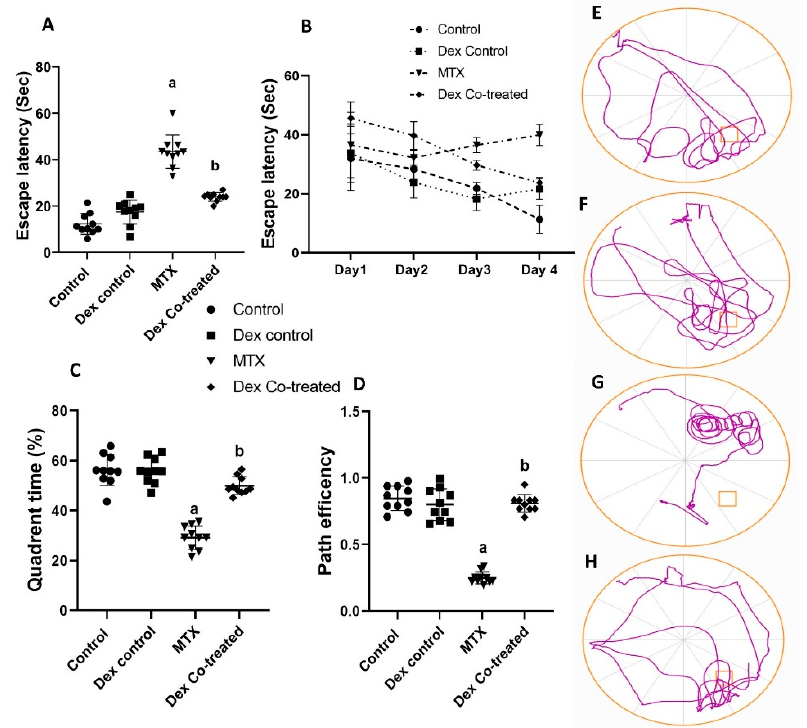
Figure 2. Cognitive and behavioral effects of MTX and Dex co-treatment (Morris water maze